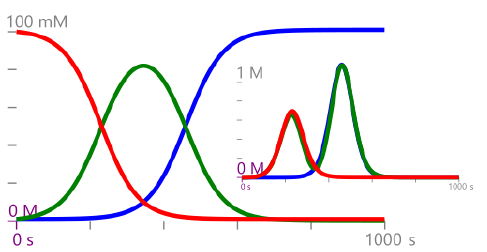
Figure 2. Evolution of µ a (red), µ b (green), µ c (blue) for the CRN reported in Example 1. Inset: the respective